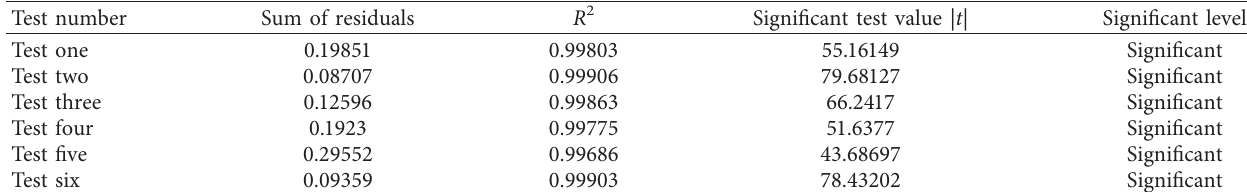
Figure 9: Comparison between calculated corrosion rate and real corrosion rate. Table 12: Reliability analysis of measuring corrosion